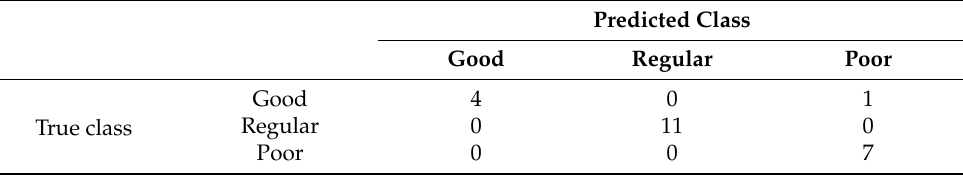
Table 13. Confusion matrix of the proposed meta-learning for the C4.5